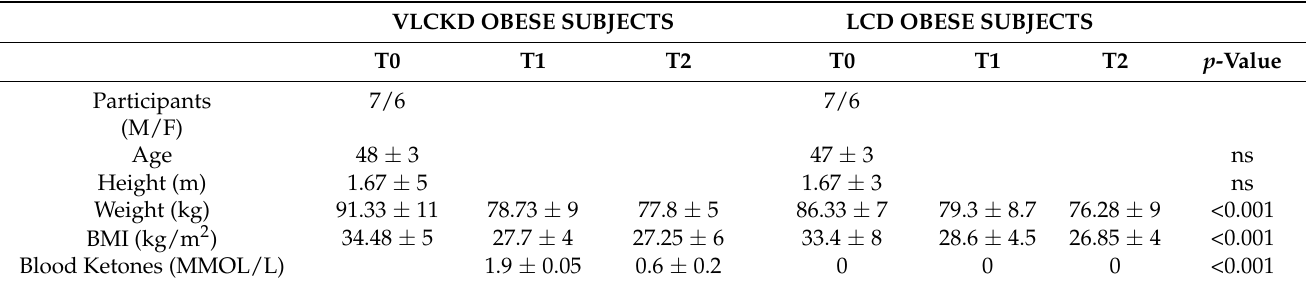
Table 1. Main Characteristics of participants.